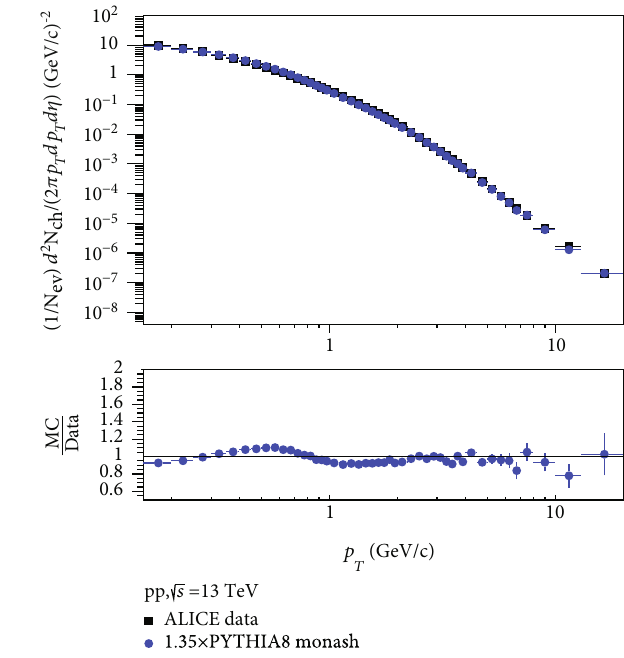
Figure 3: (Color online) Upper panel: comparison of charged ffiffi p = 13TeV between ALICE particle p spectra in pp collisions at s T data [19] and PYTHIA8 simulation, which is used for this analysis. Lower panel: the ratio between scaled simulated data and experimental data.